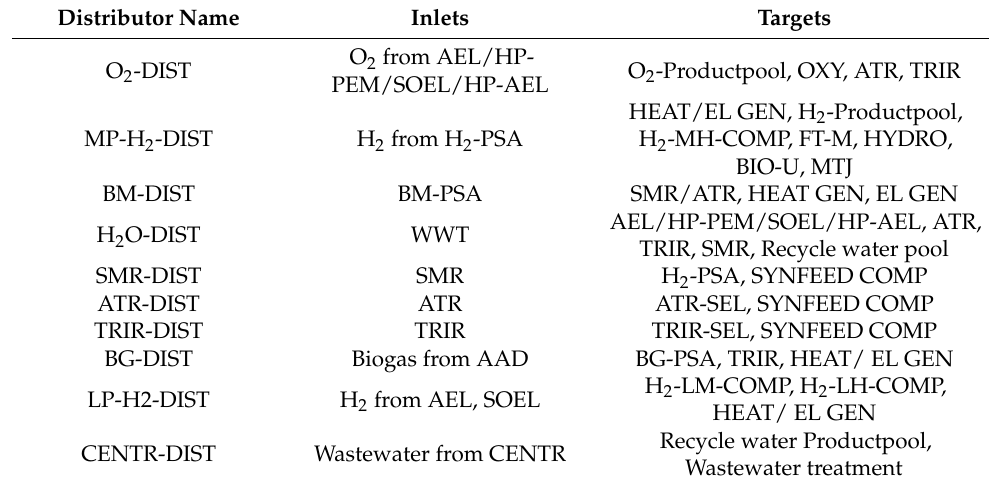
Table 5. Distributor names and process configuration of renewable refinery superstructure.